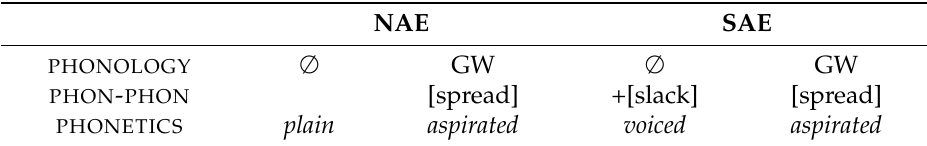
Table 2. American English laryngeal representations, completions, and